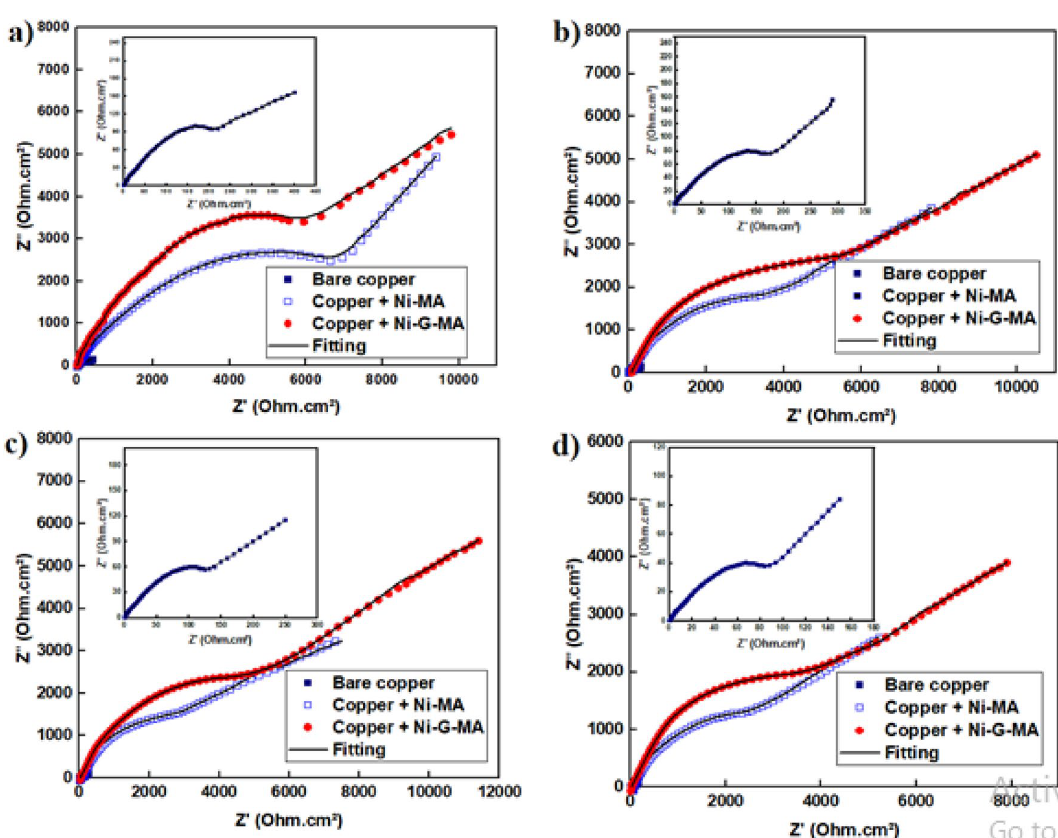
Figure 11. Nyquist plots of the bare and SHP coated copper immersed in 0.5 M NaCl solution for ( a ) 4 days, ( b ) 8 days, ( c ) 12 days, and ( d ) 16